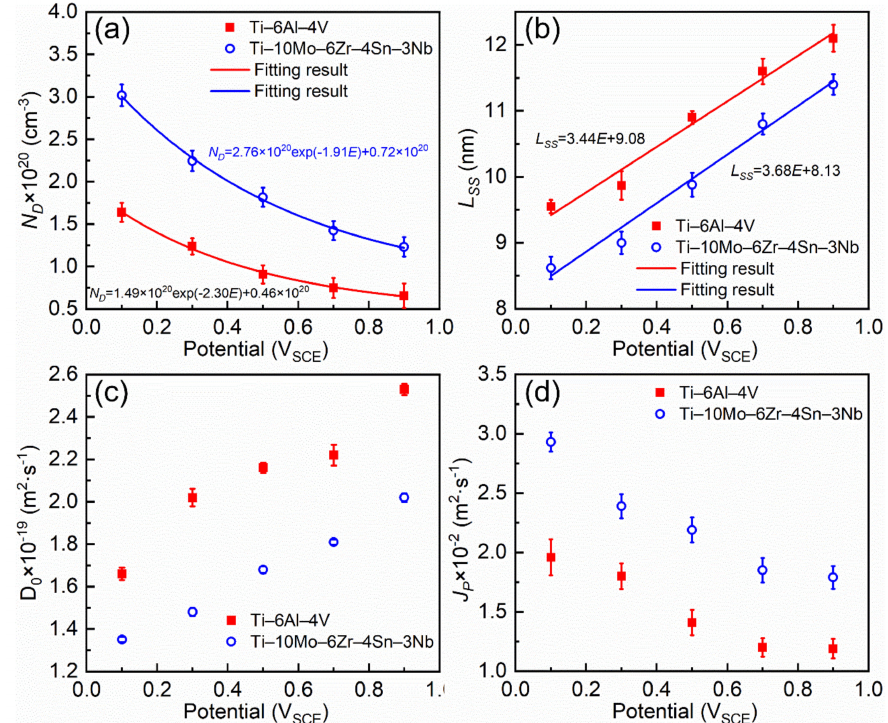
Figure 8. Semi-conductive properties of passive films formed on Ti–10Mo–6Zr–4Sn–3Nb and Ti–6Al–4V after 30 min potentiostatic polarization at 0.6–1 V SCE : ( a ) donor density, ( b ) thickness of passive film, ( c ) diffusion coefficient of oxygen vacancy, and ( d ) diffusion